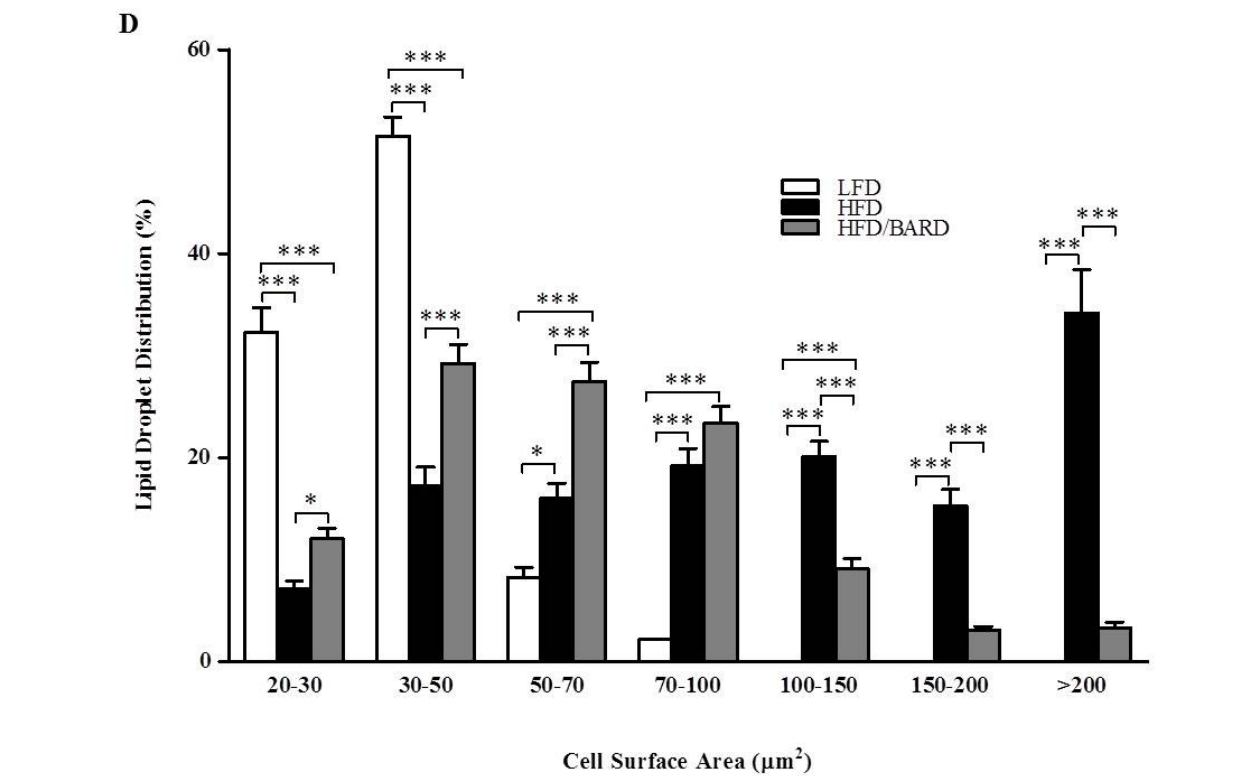
Figure 1. Effect of bardoxolone methyl (BARD) on fat deposition in brown adipose tissue of mice fed: low-fat diet (LFD), high-fat diet (HFD), and high-fat diet supplemented with BARD (HFD/BARD). ( A ) Haematoxylin and eosin staining of brown fat pads (×40). Bar = 50 µm; ( B ) Lipid area; ( C ) Lipid droplet area; ( D ) Distribution of lipid droplets. All data are presented as mean ± SEM. * p < 0.05, *** p <